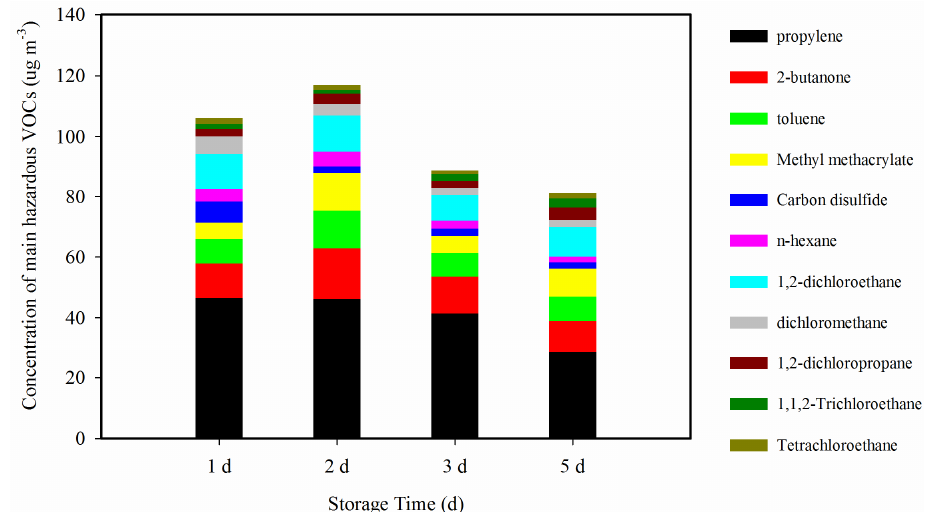
Figure 4. Changes in contents of main hazardous VOCs during five-day storage of biogas digestate.